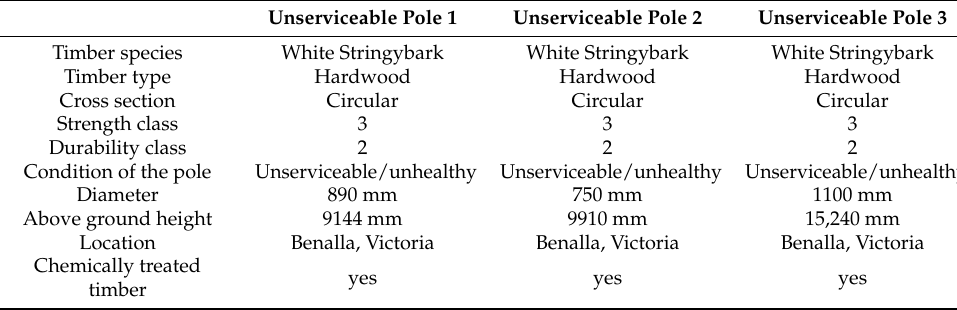
Table 4. Detail of three unserviceable timber poles.